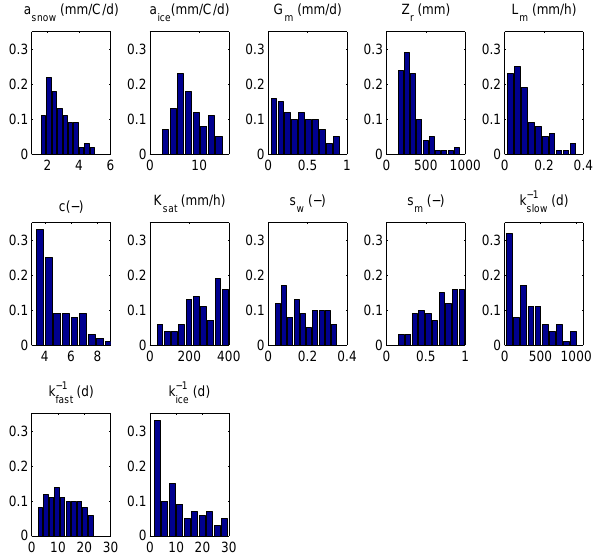
Figure 8. Parameter distributions obtained for the best 100 parame- ter sets under NSE at a daily time step. The y -axis shows the relative frequency of parameter values in each bin. s m , k slow respectively a i result from a multiplication of s w , k fast respectively a s with the dis- tribution of the corresponding calibrated scaling parameters.